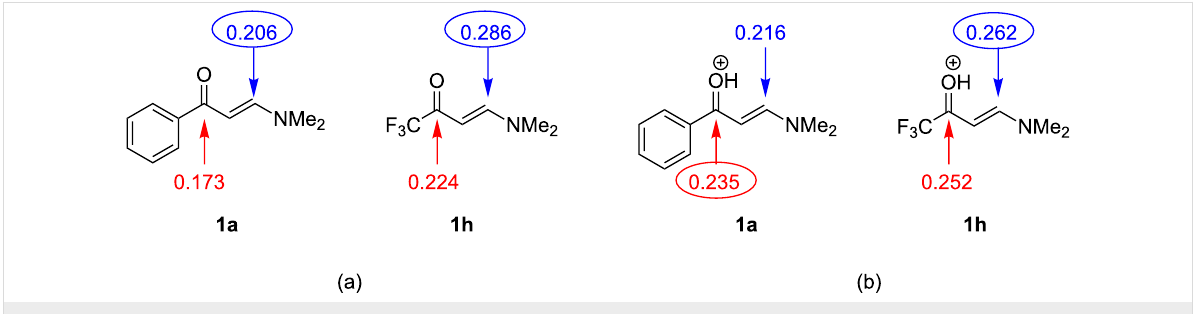
Figure 2: LUMO coefficients for (a) β -enaminones 1a , h , and their (b) conjugated acids.